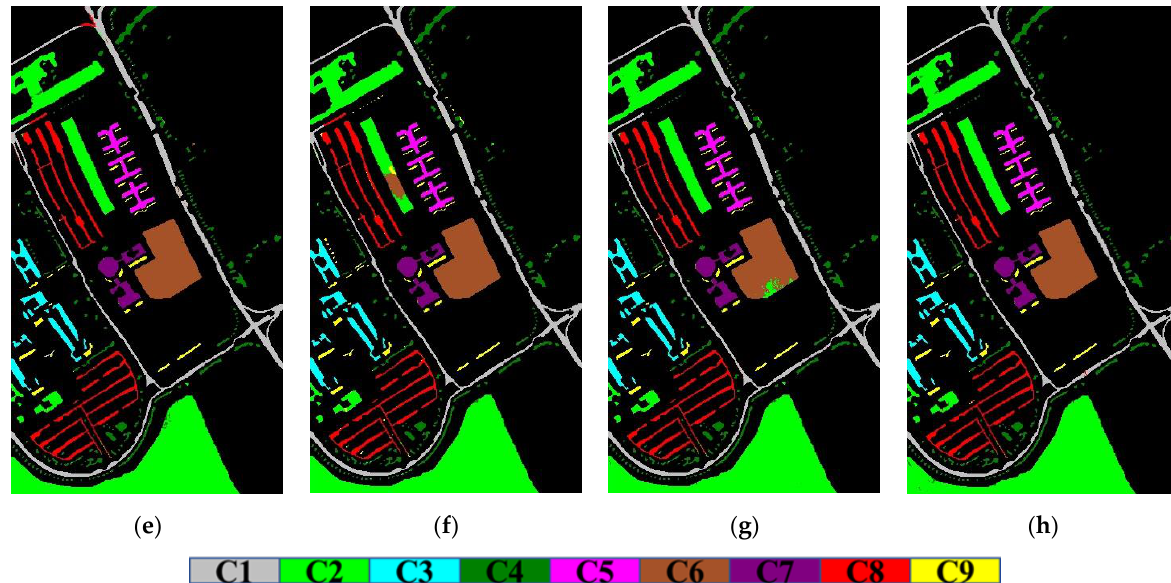
Figure 4. Classification maps for the University of Pavia image. ( a ) Ground truth; ( b ) SVM-RBF; ( c ) SVMCK; ( d ) SCMK; ( e ) RMK; ( f ) ASMGSSK; ( g ) WASCK; ( h ) MWASCK.